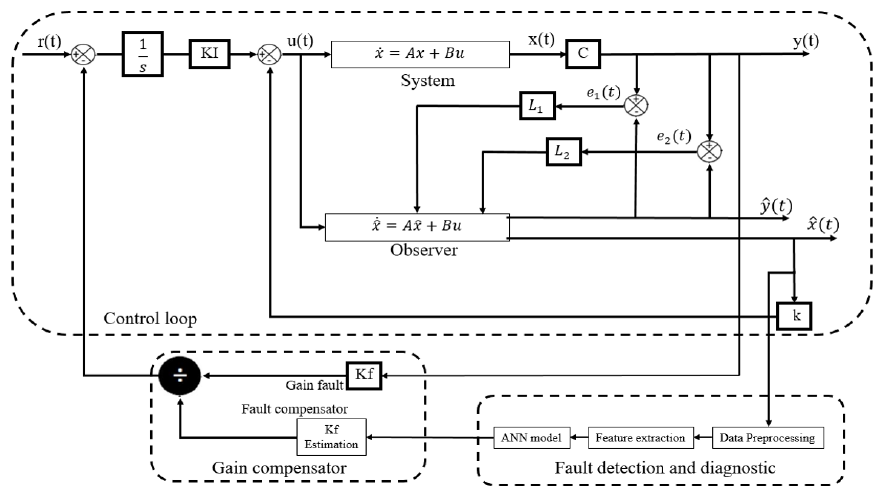
Figure 7. Fault tolerant control architecture.